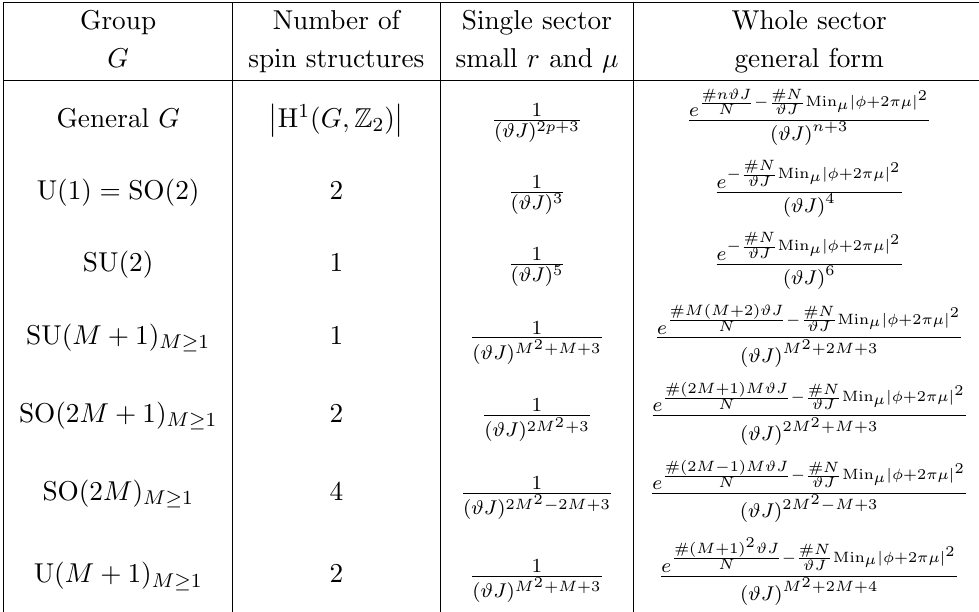
Table 1 . The spectral form factor for Sch G in the window 1 (cid:28) #J (cid:28) N